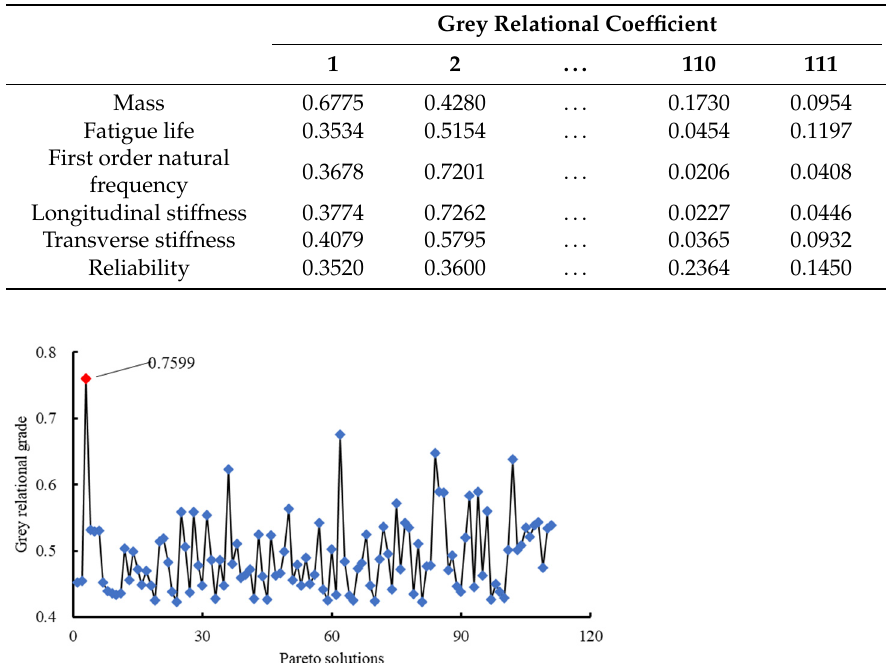
Table 6. Grey relational coefficient.